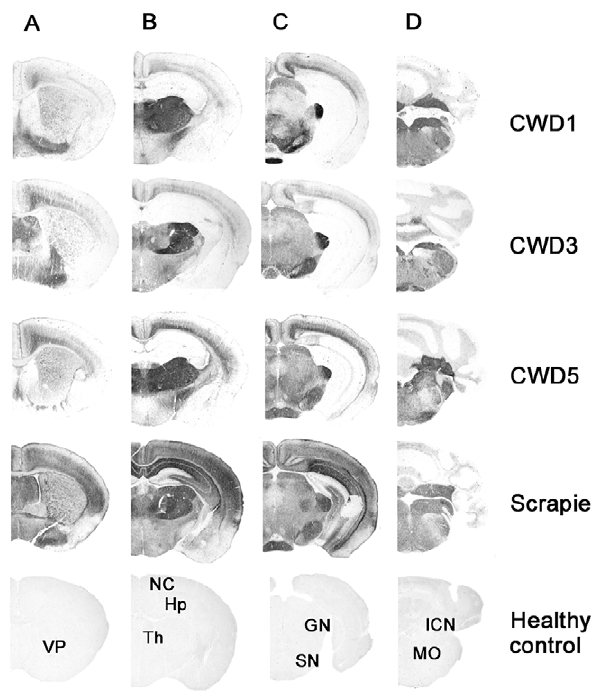
Figure 4. Regional distribution, by PET-blot, of PrP res following the third passage of CWD1, CWD3, CWD5 and sheep scrapie in Bv109I. Coronal sections of the forebrain representing: telencephalon (A), diencephalon (B), midbrain (C) and hindbrain (D). In the lower part of the figure, the labelled coronal sections of negative control brain from 150 days old Bv109I are shown: VP, ventral pallidum; NC, neocortex; Hp, hippocampus; Th, thalamus; GN, geniculate nuclei; SN, substantia nigra; ICN, interposed cerebellar nucleus; MO, medulla